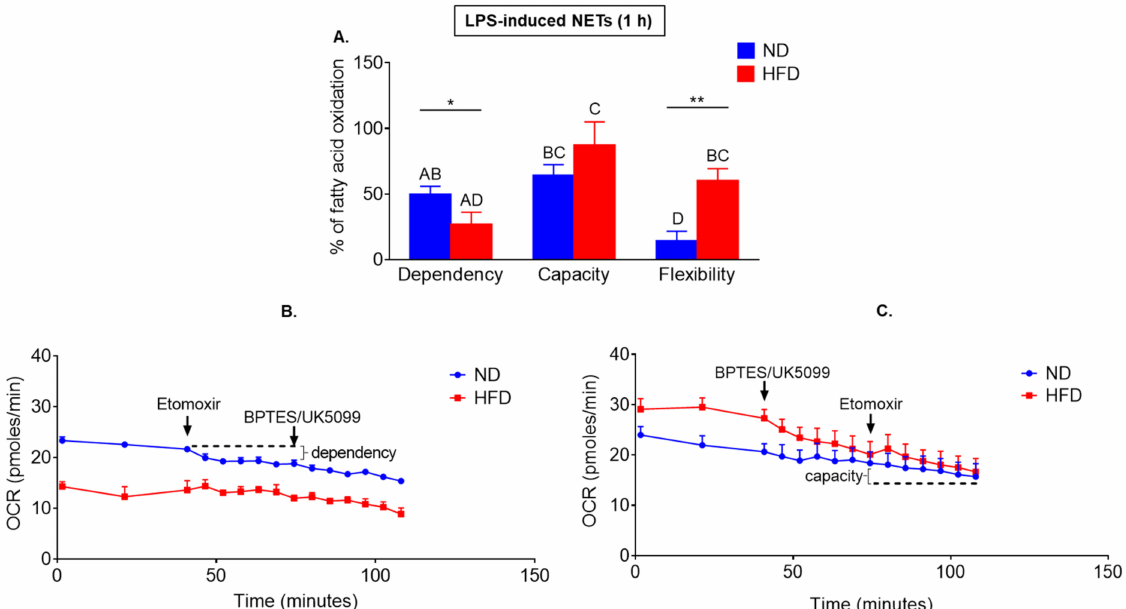
Figure 4. Comparison of fatty acid (FA) oxidation between neutrophils isolated from obese mice due to high fat diet (HFD) and their lean controls (ND). Neutrophils were collected from healthy mice. Oxygen Consumption Rate (OCR) was measured with a Seahorse analyzer applying Mito Fuel Flex Test within two hours since cell activation with lipopolysaccharide (LPS). Two parameters were directly evaluated: neutrophil dependency on FA oxidation ( A , B ), cell capacity to oxidize FA ( A , C ). Fuel flexibility of the cells was recalculated as difference between their capacity and dependency. Data quantification is shown in ( A ), and representative Seahorse readouts in ( B , C ), where ( B ) presents measurement steps and readouts for dependency, and ( C ) for capacity. Asterisks indicate significant differences between groups according to unpaired two-tailed Student’s t -test (* p ≤ 0.05, ** p ≤ 0.01). Results of one-way ANOVA (post hoc Bonferroni): any two means that do not